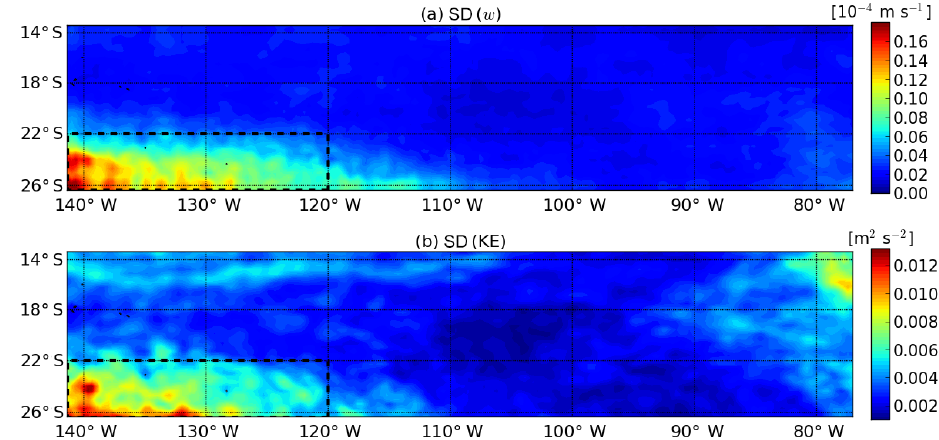
Figure 4. (a) Standard deviation of vertical velocity and (b) kinetic energy over the period 7 January 1998 to 30 December 2009 at 200m depth. The discontinuous line delimits the region of high mesoscale